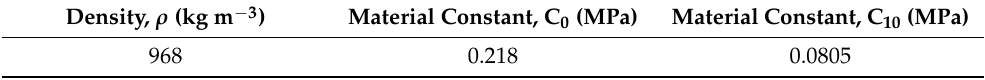
Figure 5. Eroded nodes after an impact. Table 2. Bird Material Parameters [31].